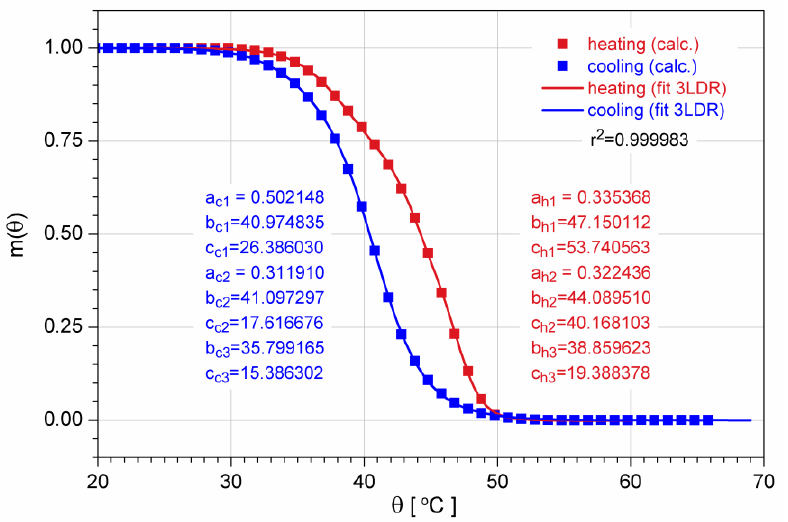
Figure 9. Temperature dependence of the martensite volume fraction of the Ti-Ni-Cu film along the forward and reverse thermal cycle, which includes the MPT (symbols: experiment-generated data, solid lines: eye guiding, fitting parameters, and coefficient of determination also included.